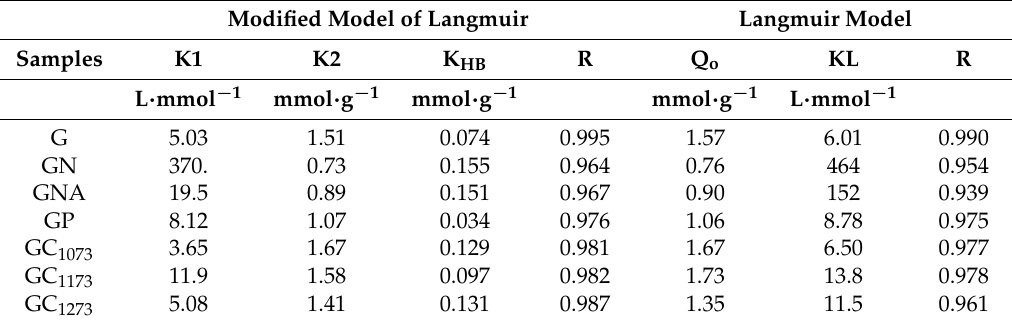
Table 4. Adjustment parameters to the Langmuir and Langmuir modified models for the adsorption of phenol from aqueous solution in equilibrium.